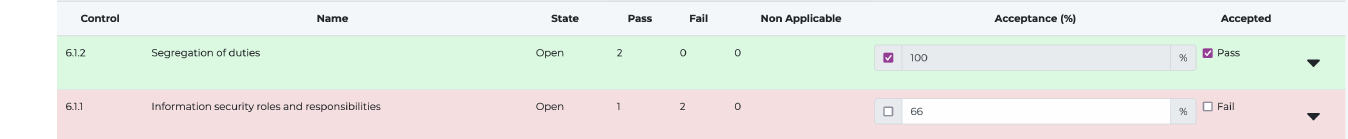
Figure 8. An example of the user interface and the level of information